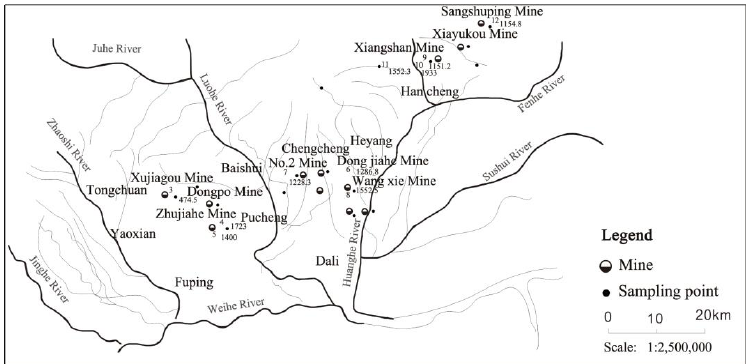
Figure 6. TDS contour line of Carboniferous sandstone (limestone) aquifer.